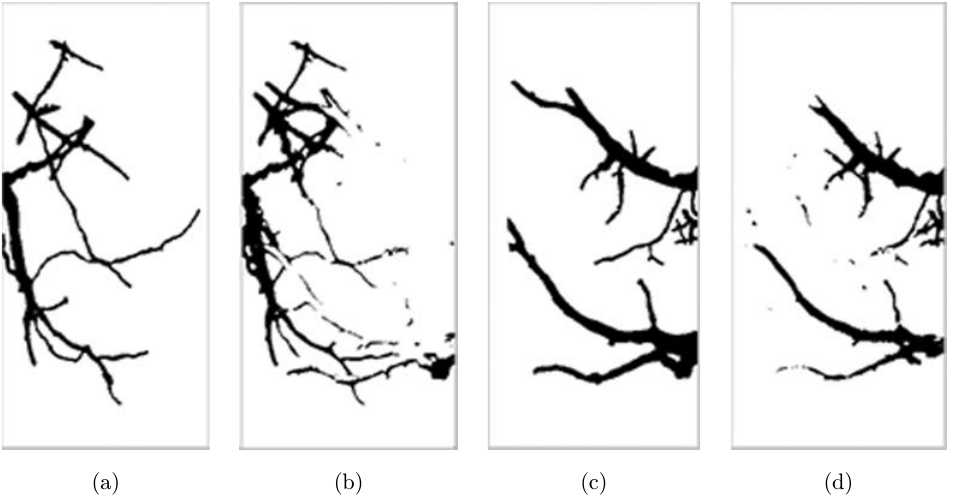
Fig. 6. Arteries and veins (a) arteries criterion (b) the segmentation of arteries (c) vein criterion (d) the segmentation of